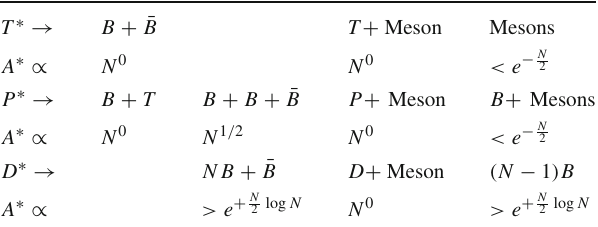
Table 1 Decay amplitudes for the decay of multiquark hadrons from states with only one quark excited, A ∗ . Amplitudes are normalised so √ N ! factor from the phase space of that | A ∗ | 2 = (cid:4) , thus including a 1 / O ( N ) indistinguishable particles, see text. Entries in the Table give the leading N dependence. The first two columns refer to decays obtained from Fig. 1 by cutting one or more QCD strings with a q ¯ q pair, the third column to the decay of an excited into the ground state by one meson emission. For multi-meson or multi-baryon decay